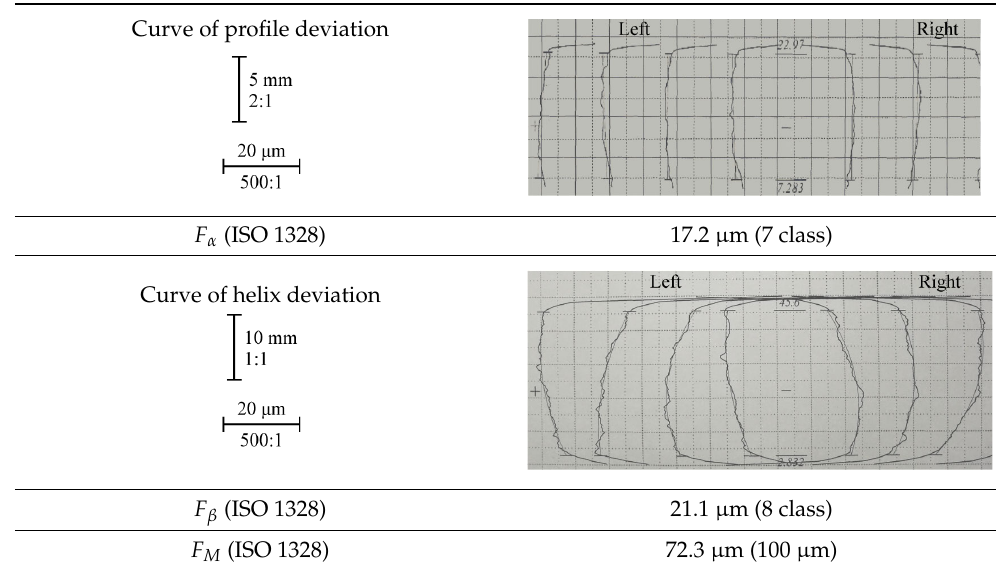
Figure 12. Finished sun gear: ( a ) Outer tooth shape and ( b ) inner tooth shape.